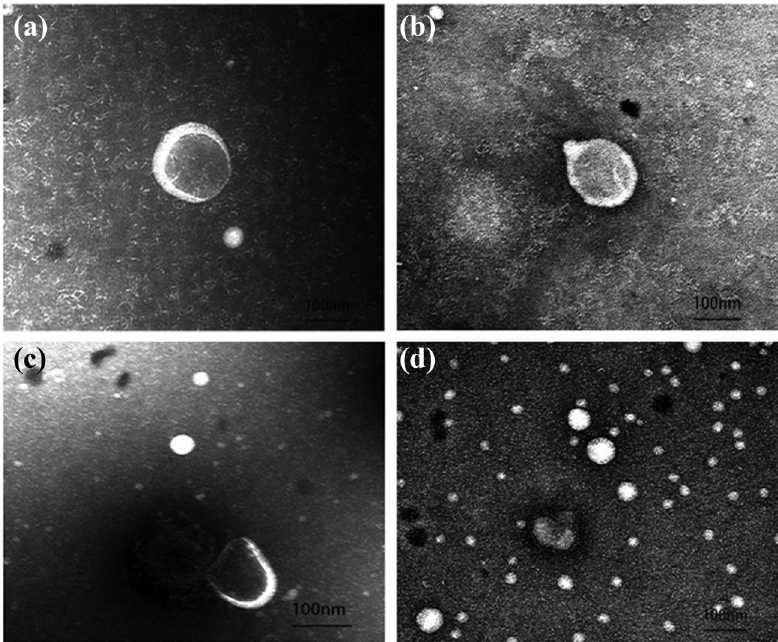
Figure 2: Electron microscopic image of exosomes following di ff erent isolation methods. Morphology of exosomes ( white arrow indicate ) isolated using ( a ) ultracentrifugation, ( b ) fi lter + ultracentrifugation, ( c ) membrane a ffi nity, ( d ) and polymer precipitation. Cup - shaped vesicles with a heterogeneous size ( 50 – 200 nm diameter ) were clearly visualized in all preparations. The bars indicate 100